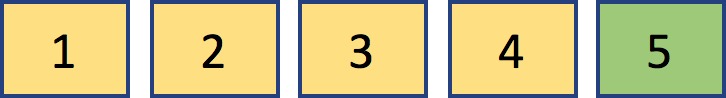
Cross-validation scheme.For each subject, we train our classifier on all (yellow) but one session and test the performance on the hold-out session (green) and repeat the procedure for each session.